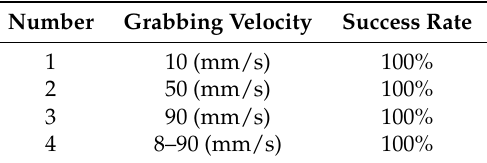
Figure 11. Pose estimation of an incomplete information workpiece. Table 5. Dynamic grasp